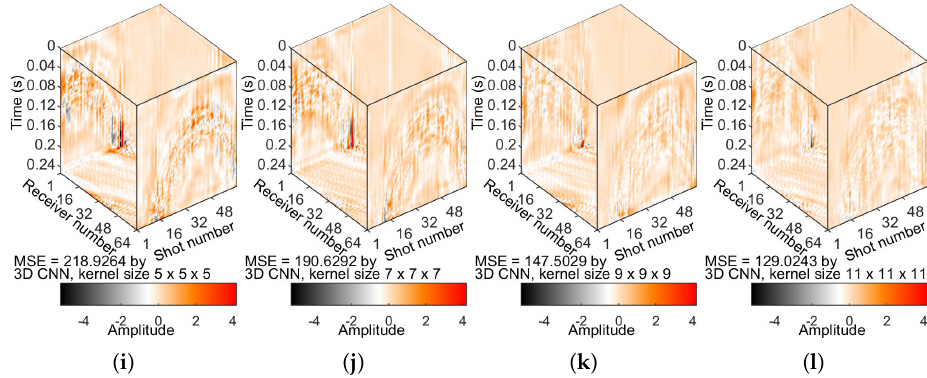
Figure 7. Tests on the Marmousi2 open dataset. ( a ) Prestack seismic data. ( b ) True LF data (<5 Hz). ( c ) The best LFR result (within 50 epochs) predicted by 2D CNN with a kernel size of 11 × 11. To generate the 2D CNN results in panel ( c ) (and in the following Figure 9c), we feed each shot (i.e., a 2D matrix) into a trained 2D CNN in a one-by-one manner using the same settings as the 3D CNN method. That is, shot gathers of a line are processed by the 2D CNN method in the shot-by-shot manner. Panels ( d – h ) show the best LFR result (within 50 epochs) predicted by the 3D CNN method with kernel sizes of 3 × 3 × 3, 5 × 5 × 5, 7 × 7 × 7, 9 × 9 × 9, and 11 × 11 × 11, respectively. Panels ( i – l ) show the LFR residuals generated by the 3D CNN method with kernel sizes of 5 × 5 × 5, 7 × 7 × 7, 9 × 9 × 9, and 11 × 11 × 11, respectively.